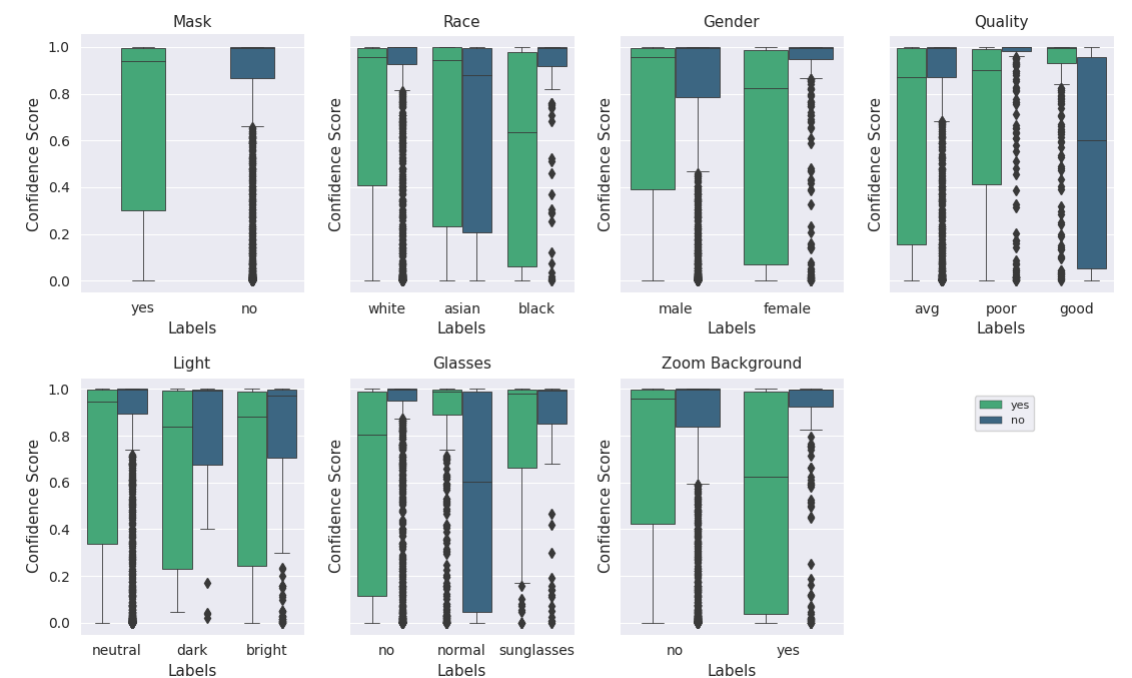
Figure A2. Box plot of categorical labels vs. confidence scores for all image qualities, as evaluated via BRISQUE, using the augmented MobileNetv2 model. For each category and its labels, ‘mask’ and ‘no mask’ scores are plotted beside each other. The median is represented by the center line of each box while the upper and lower bounds represent the respective quartiles. Outliers are represented by diamond symbols. The primary difference between this plot and Figure A1 is the ‘Quality’ subplot, which shows the difference in the original subjective and the BRISQUE quantitative quality categories.